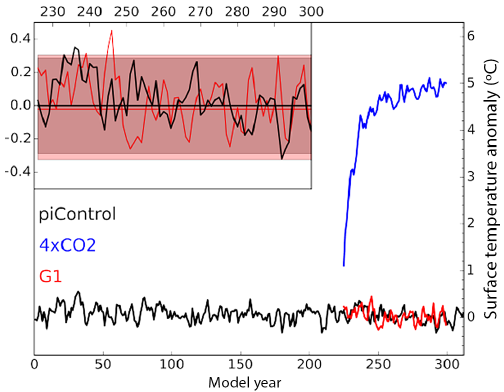
Figure 1. Temporal evolution of the annual and global mean sur- face temperature anomalies. The anomalies ( ◦ C) are shown relative to the average temperature of the pre-industrial experiment. The pi- Control and G1 experiment are highlighted in the inset panel with the straight lines marking the average temperature anomalies. The grey and red shading give the ± 2 σ temperature interval for piCon- trol and G1